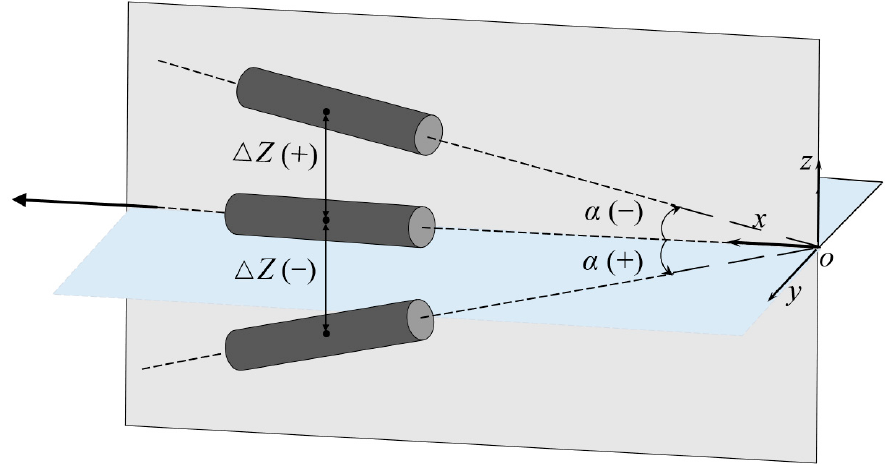
Figure 7. Schematic diagram of the definition of the kinematic parameters of a projectile.